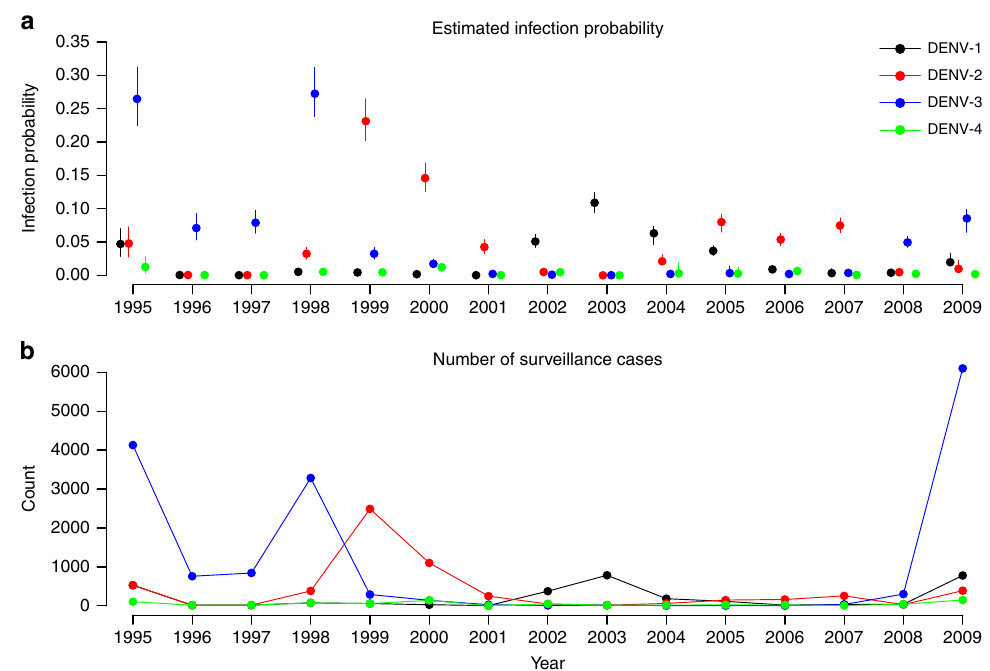
Fig. 1 Estimated probabilities of infection and reported numbers of cases by serotype and year. Serotypes are colored in black for DENV-1, red for DENV-2, blue for DENV-3, and green for DENV-4. a The model-predicted serotype-speci fi c probabilities of infection. Points and vertical bars indicate posterior medians and 95% credible intervals. b The number of surveillance-reported cases in Managua, Nicaragua, from 1995 to 2009. The year is de fi ned as July of a year to June of the next year, to be consistent with the dengue season in the study region. Serotype-speci fi c surveillance counts were imputed using information obtained from PAHO and literature (Supplementary Methods). Source data are provided as a Source Data fi